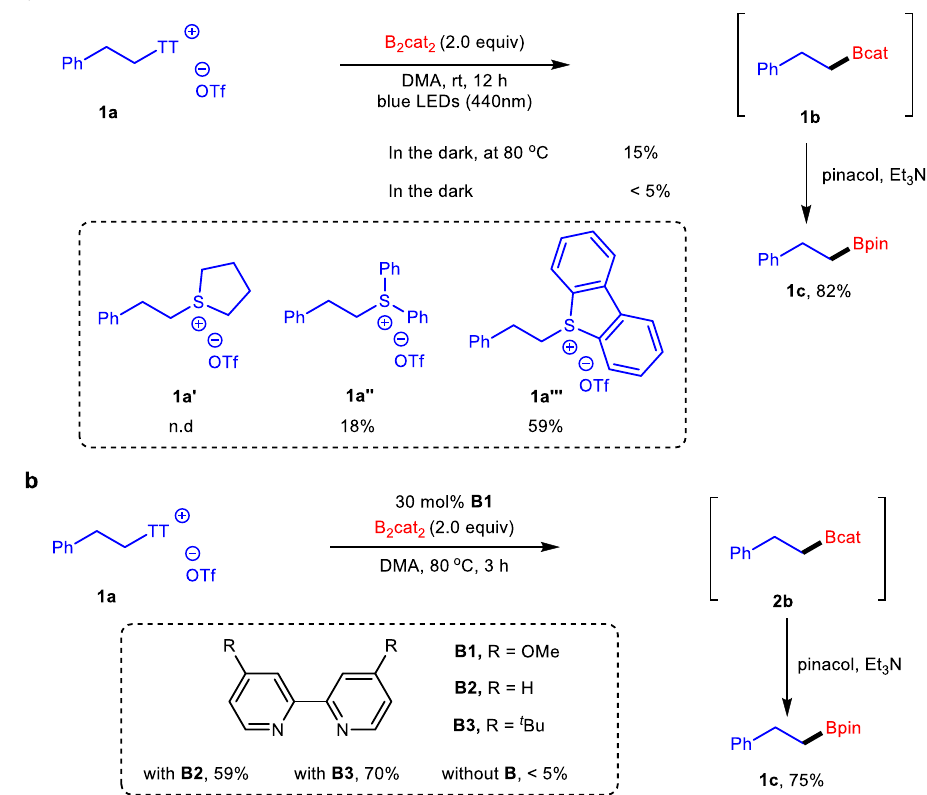
Fig. 3 Desulfurative borylation of thianthrenium salt 1a. a Photoinduced desulfurative borylation. b Thermoinduced desulfurative borylation by Lewis